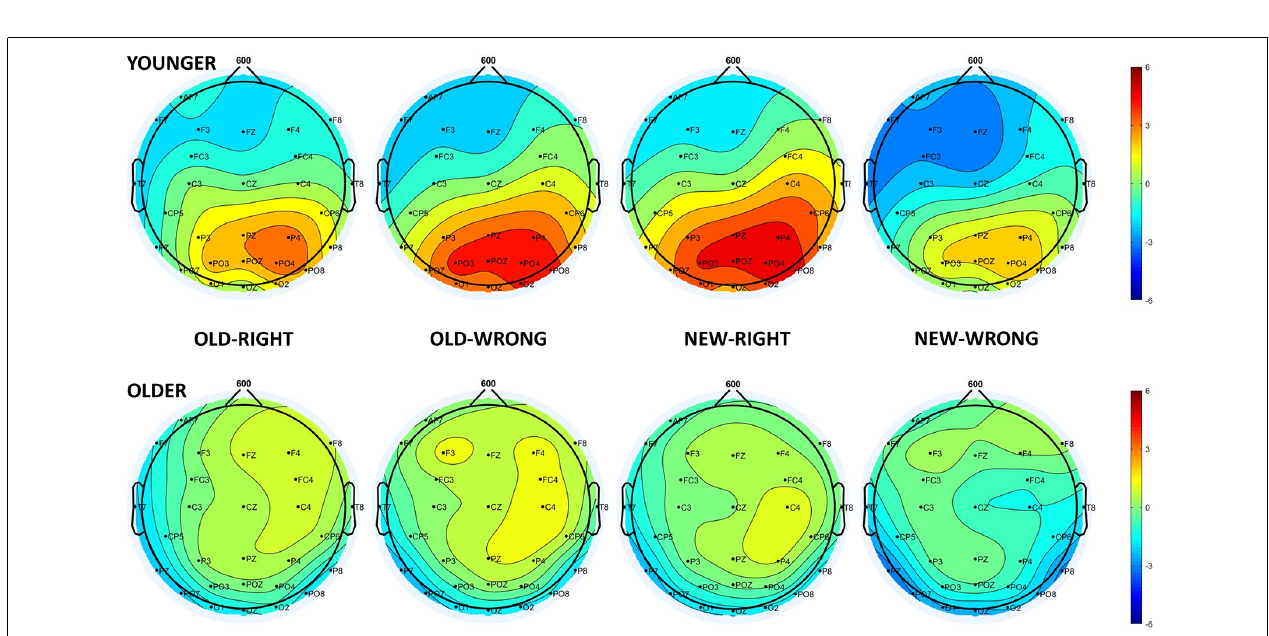
FIGURE 4 | Test stimuli-locked late positive component (LPC) at the Pz electrode site in younger (left side) and older adults (right side). The 0 ms time point on the x-axis is locked to the test face presentation and it represents the ( − 100, 1,000 ms) interval. The presented waveforms are following the test responses (presented face—new/old and the participant’s response—right/wrong) and shown by the following colors: New-Right (red), Old-Right (black), New-Wrong (blue), Old-Wrong (green). The gray rectangle shows the 500–700 ms time window in which we searched for the LPC.